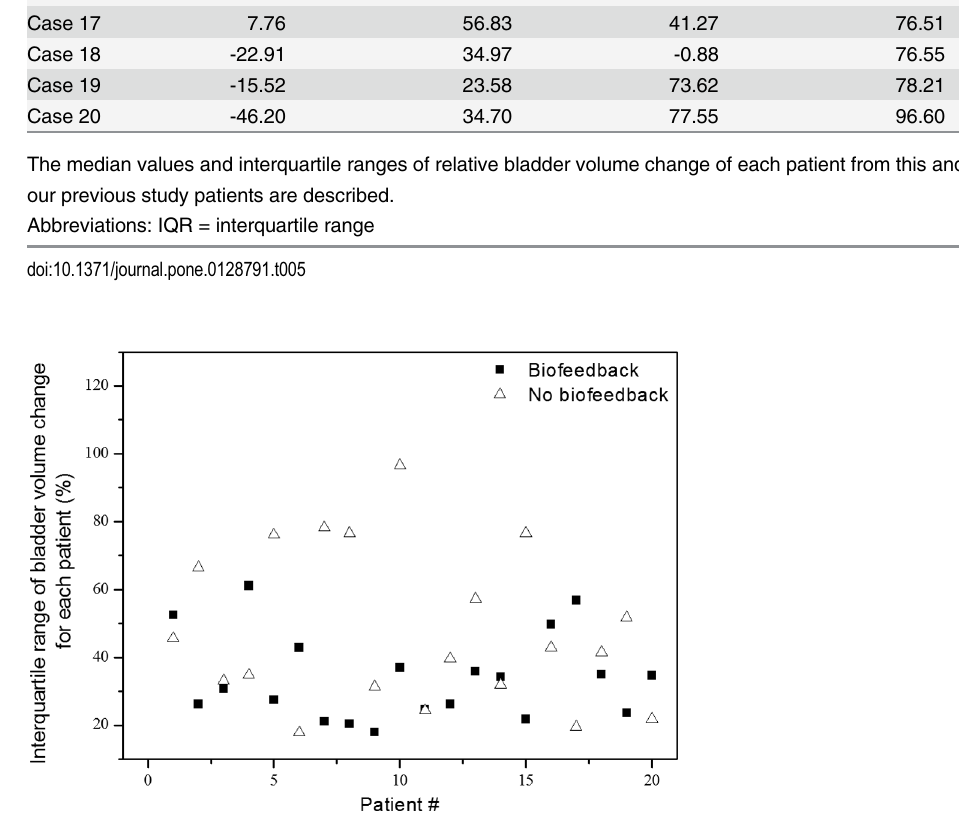
Fig 2. The distribution of interquartile range of relative bladder volume change according to protocol- based maintenance. The interquartile range of relative bladder volume change for patients receiving protocol-based full bladder maintenance (black squares) had smaller variation than that of patients performing self-controlled maintenance (open